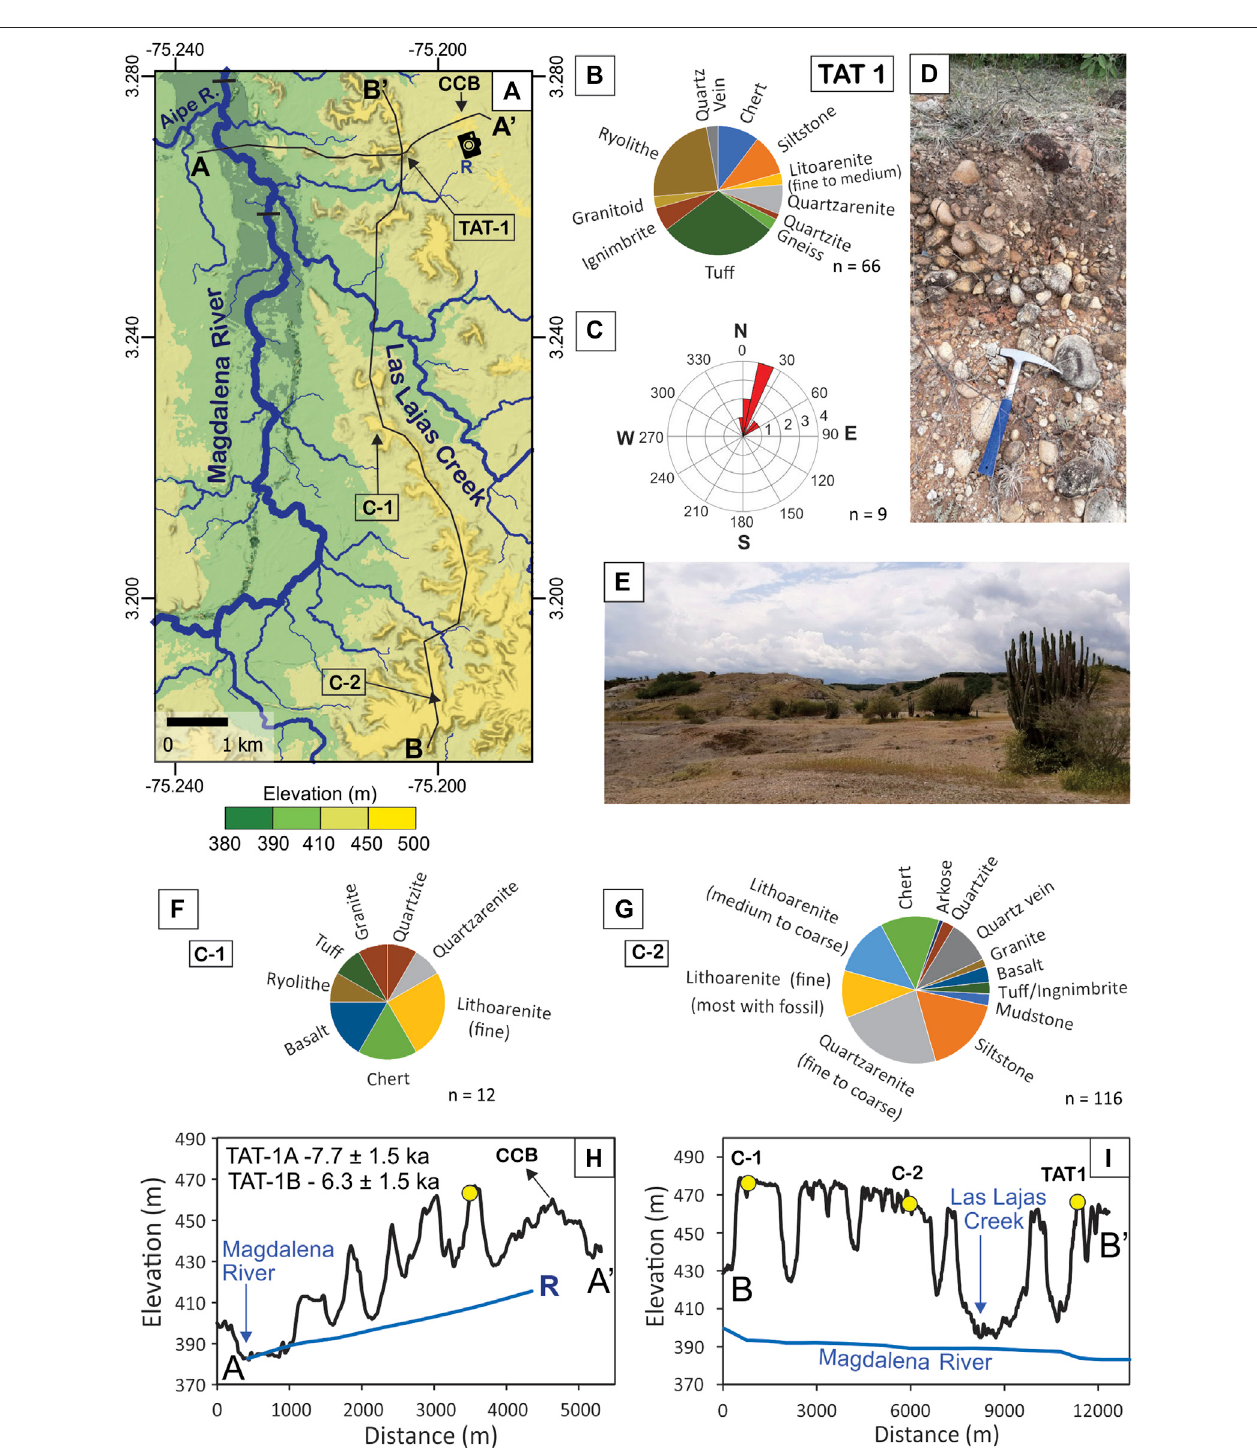
FIGURE4| DetailoftheTAT-1samplingsite. (A) Digitalelevationmodel(TanDEM-X),12 m;shadedareasarehillslopeshigherthan25 ° .Thetwosmalltraces(black lines)acrosstheMagdalenaRiverneartheA-Apro fi ledelimitthesegmentusedtoextracttherivermeanelevationforincisionratescalculation.CCBistheoutcroppingof CerbatanaConglomerateBeds; (B) modalgravelcompositionforlocalityTAT-1; (C) paleocurrentdirectionforTAT-1(rawdatain SupplementaryTableS5 ); (D) picture with detail of the − 1.2 m thick deposit; (E) picture with a view from the NE of the terraces (picture location shown in (A) , (F) modal gravel composition for the controllingpointC-1; (G) modalgravelcompositionforthecontrollingpointC-2; (H) topographicA-A ′ pro fi leandareferenceriverpro fi le;thesamplelocation(yellowdot) and OSL-ages are shown; and (I) topographic B-B ′ pro fi le and a reference river pro fi le, with sample location and OSL-ages shown.